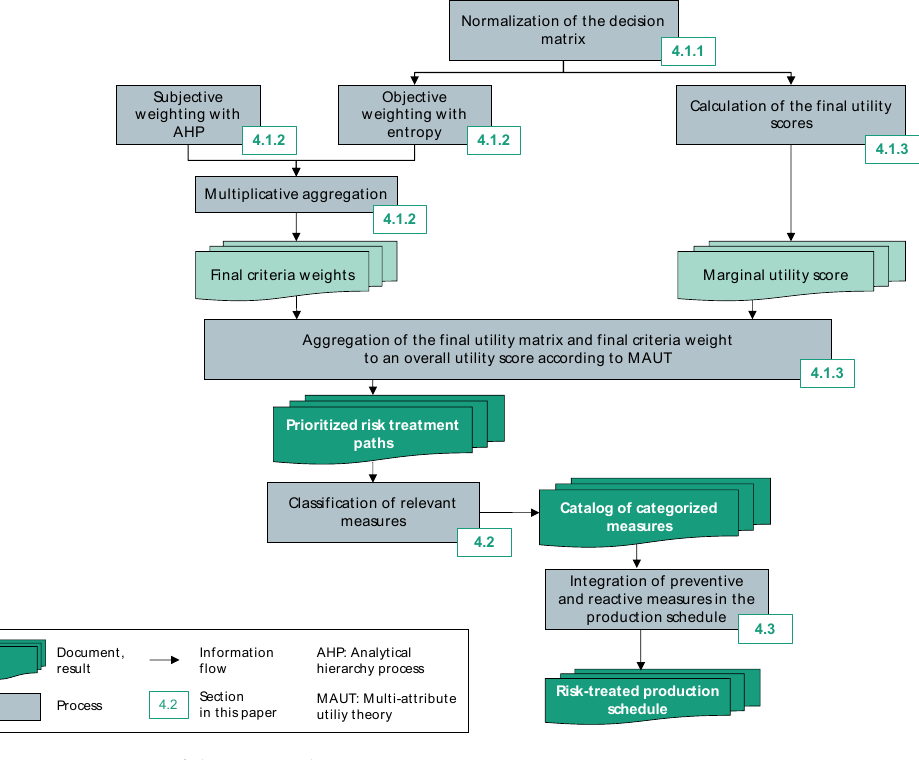
Figure 2. Overview of the approach.